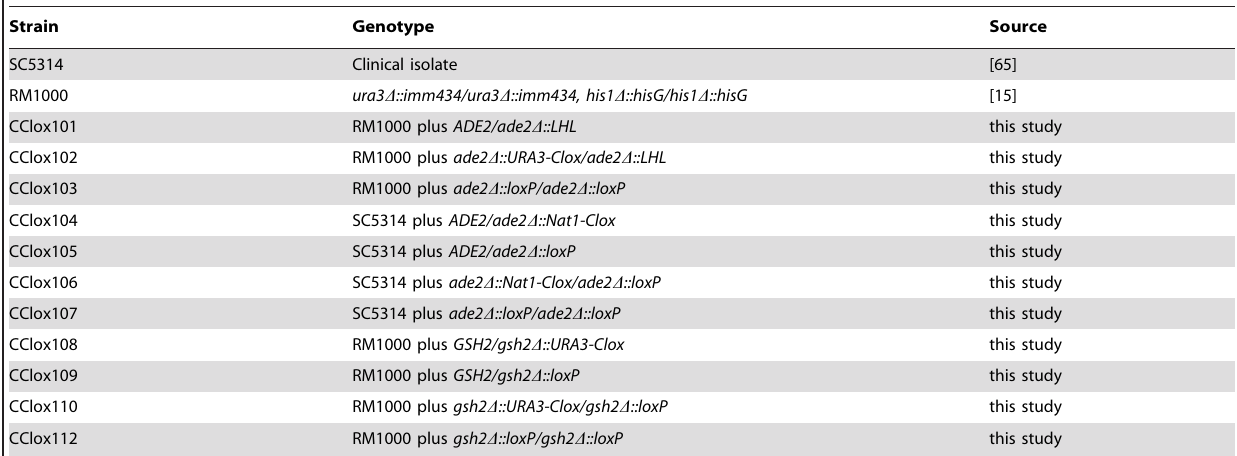
Table 1. Strains used in this study.